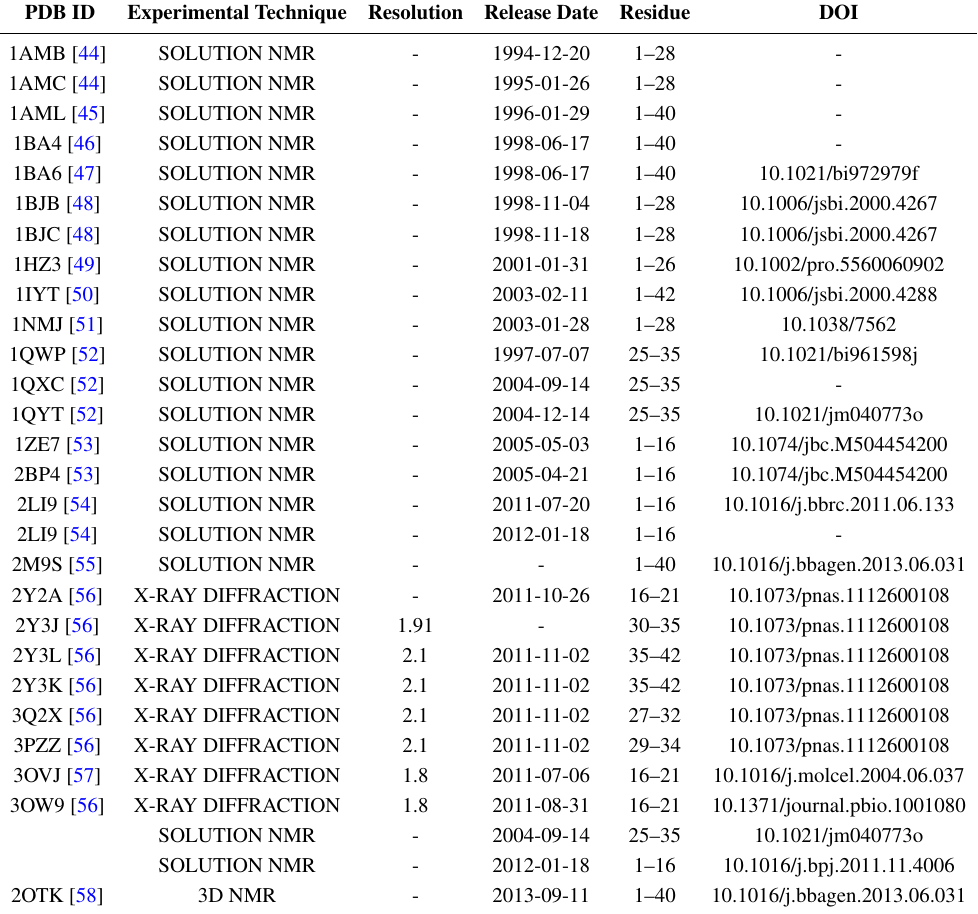
Table 1. Structural data of amyloid beta peptide obtained from